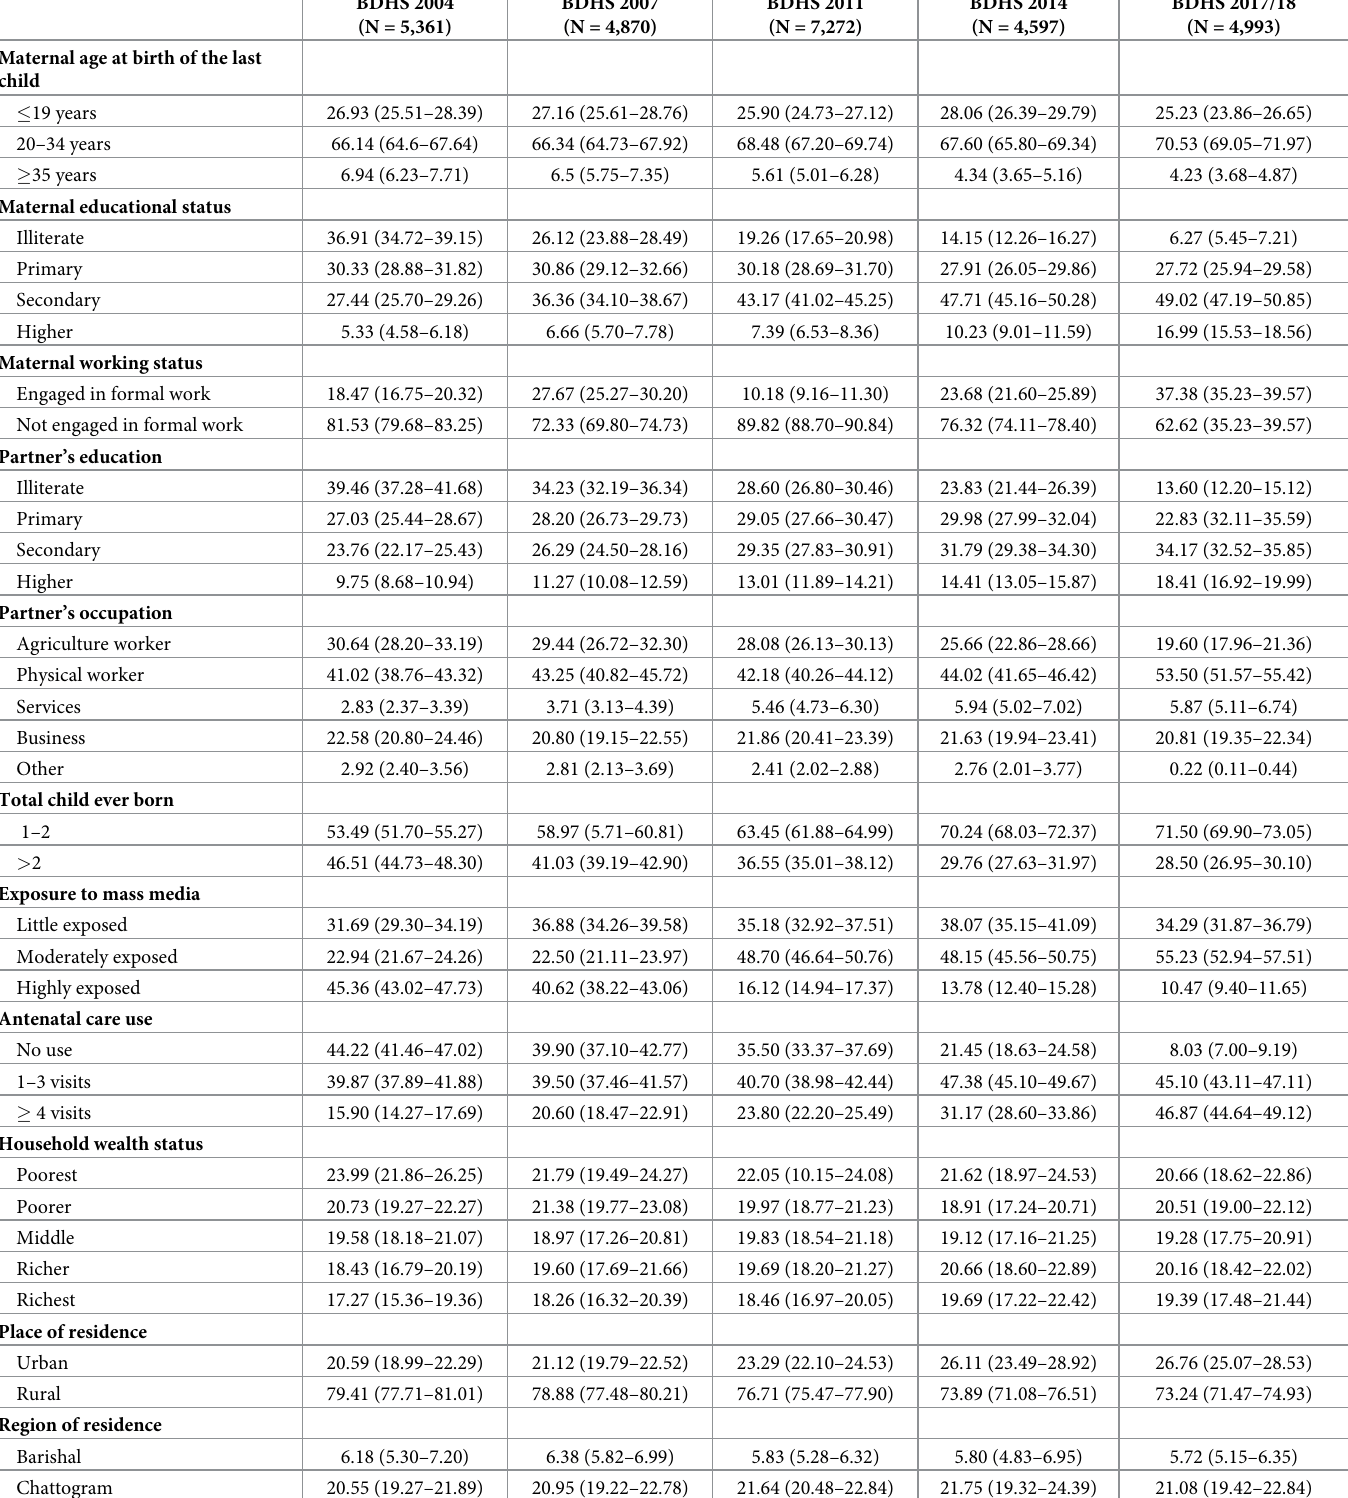
Table 1. Background characteristics of the respondents, BDHS 2004- BDHS